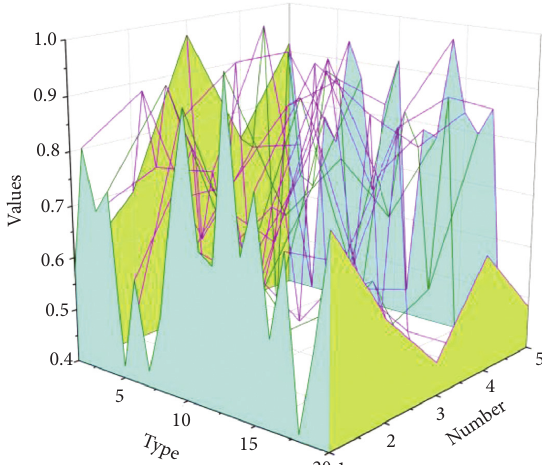
Figure 5: Distribution of telecommunications fraud viruses in household electronic